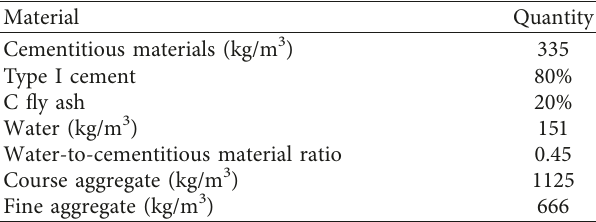
Figure 5: Sample exposed to 3% NaCl solution showing washed aggregate on the corner. Table 1: Mixture proportions.